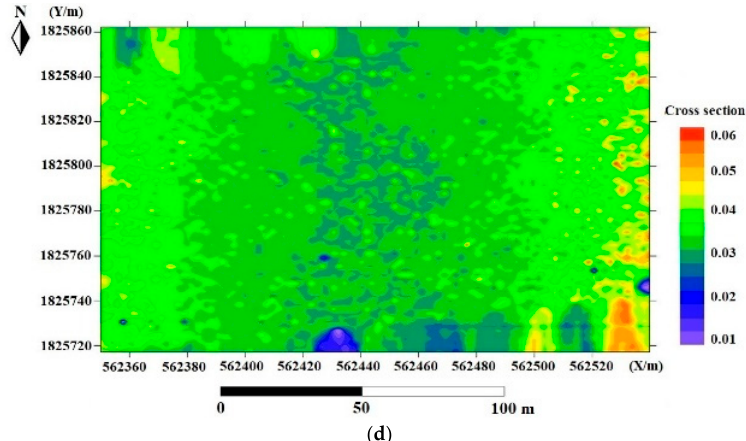
Figure 6. LiDAR waveform parameters: ( a ) skewness; ( b ) kurtosis; ( c ) amplitude; ( d ) cross-section. (Measuring point density is 10–20 points/m 2 , plane coordinate is WGS_1984_UTM_Zone_49N coordinate in meters). Table 3. Evaluation of classification results based on LiDAR waveform features. Model No.